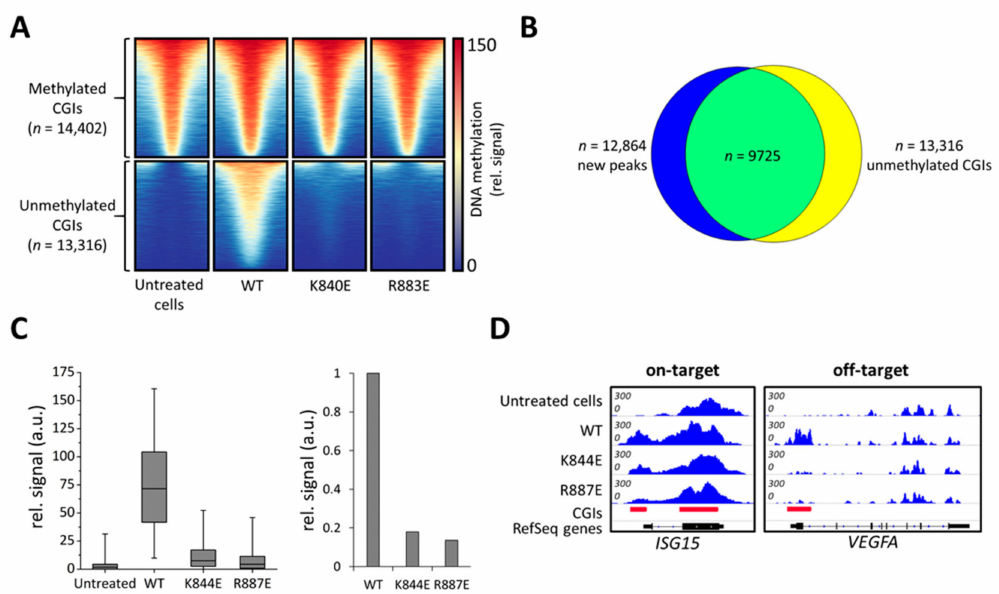
Figure 4. Genome-wide analysis of o ff -target DNA methylation in cells treated with dCS, Ab-3A3L with wild type or mutant DNMT3A parts, and ISG15 sgRNA. ( A ) Heatmap showing DNA methylation centered around CGIs ± 1 kb. Untreated cells contain methylated and unmethylated CGIs, which are separated into two groups shown in the upper and lower panels. The wild type DNMT3A (WT) construct caused a very strong de novo methylation in previously unmethylated CGIs, whereas K844E and R887E showed drastically lower methylation. ( B ) Intersection of new DNA methylation peaks generated by the wild type DNMT3A (WT) and the group of unmethylated CGIs taken from (A). ( C ) Boxplot showing a quantification of MBD-seq data sets using the group of unmethylated CGIs from (A) (line = median, box = 25th and 75th percentile, whiskers = 5th and 95th percentile). The bar diagram shows average signals in unmethylated CGIs normalized to wild type (WT). ( D ) Integrative Genomics Viewer (IGV) browser views of MBD-seq data displayed for the ISG15 (chr1:948,441-950,302, hg19) and VEGFA (chr6:43,736,149-43,754,992, hg19) regions. For quantification and additional o ff -target loci, see Figures S4 and